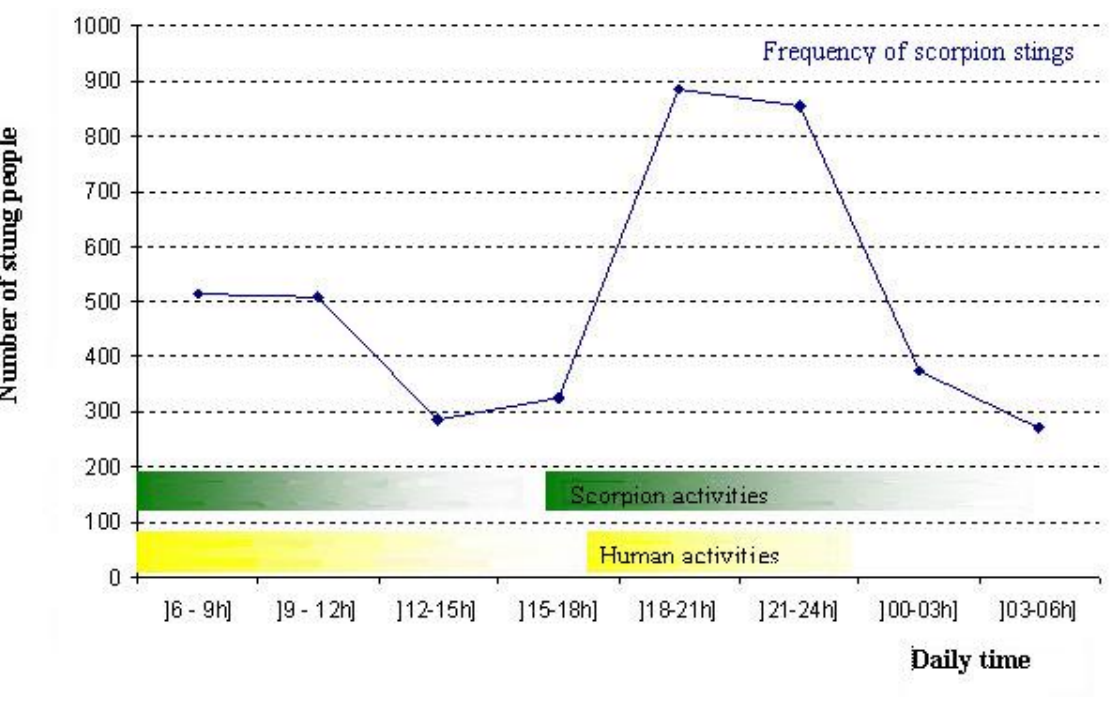
Figure 1: Frequency of scorpion stings according to periods of human and scorpion activities. Note that maximum scorpion and human activities were between 6:00